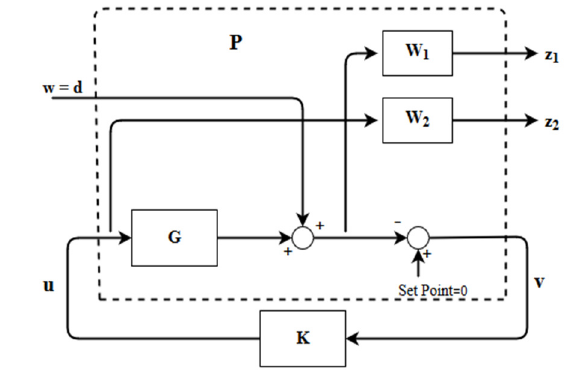
Fig. 4. Mixed Sensitivity in Standard Form (Disturbance H h